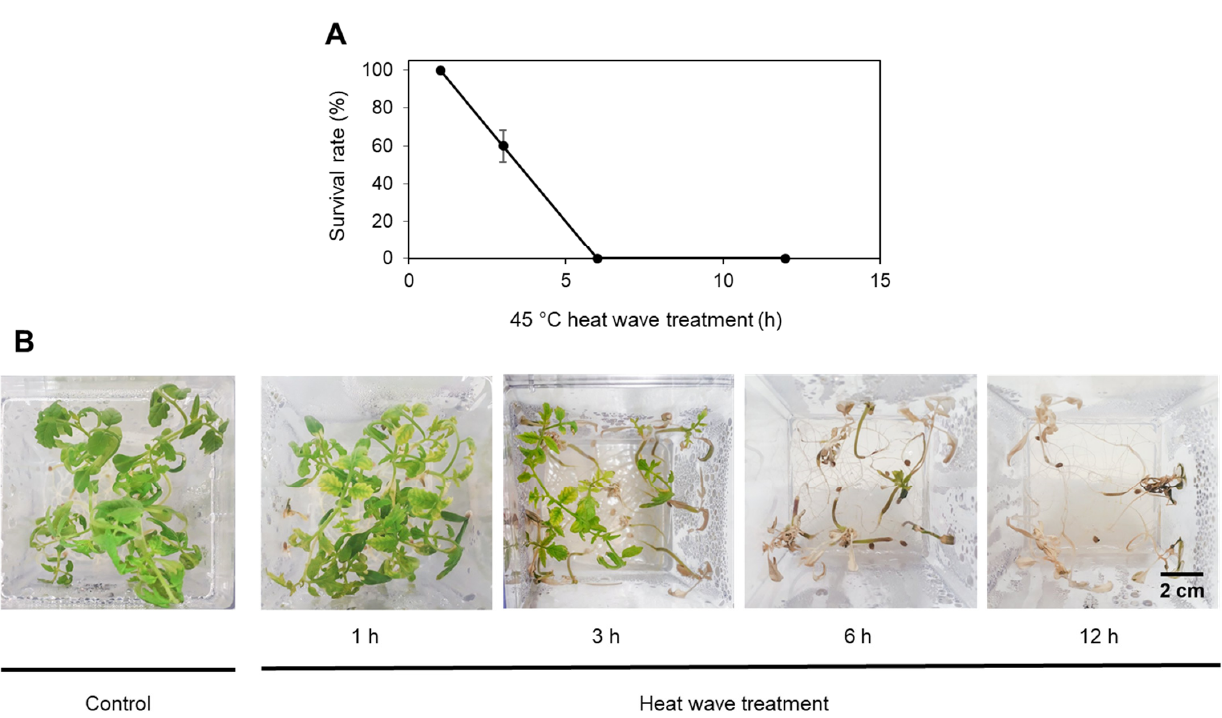
Figure 2. Heat stress tolerance in tomato seedlings. Twelve-day-old seedlings were exposed to 45 °C for 1, 3, 6 and 12 h. Control plants were kept at 24 °C. Survival rates ( A ) were estimated following a 7-day recovery period (Figure S1A). Green seedlings still producing new leaves were scored as survived. Pictures were taken after the 7-day recovery ( B ). Each biological replicate consisted of 15 seedlings. Data represent the mean of 3 replicates with standard deviations denoted by vertical bars. The scale bar is 2 cm.